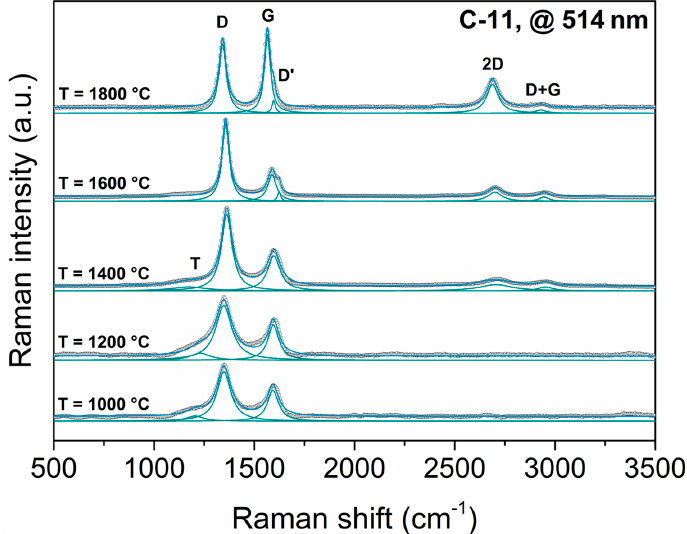
Figure 1. Raman spectra of sample C-11 heat-treated at different temperatures in the range from 1000 to 1800 °C (laser wavelength was 514 nm). Green lines represent deconvoluted bands, black circles indicate the experimental curve and the blue line is the fitted curve.